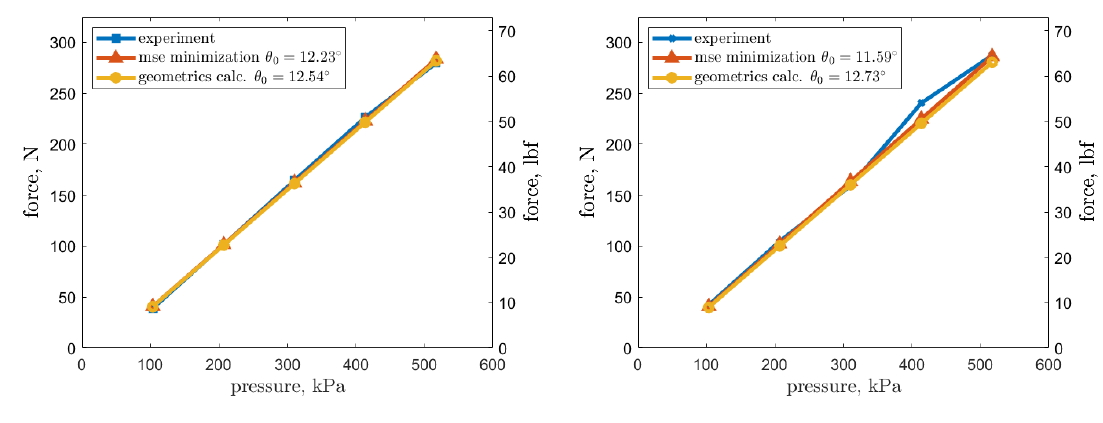
Figure 8. For the two extensile FAMs, blocked force was plotted based on the Gaylord’s force model, Equation (9). Braid angle was found based on geometric properties of fabricated FAMs, and with error minimization with respect to the experimental